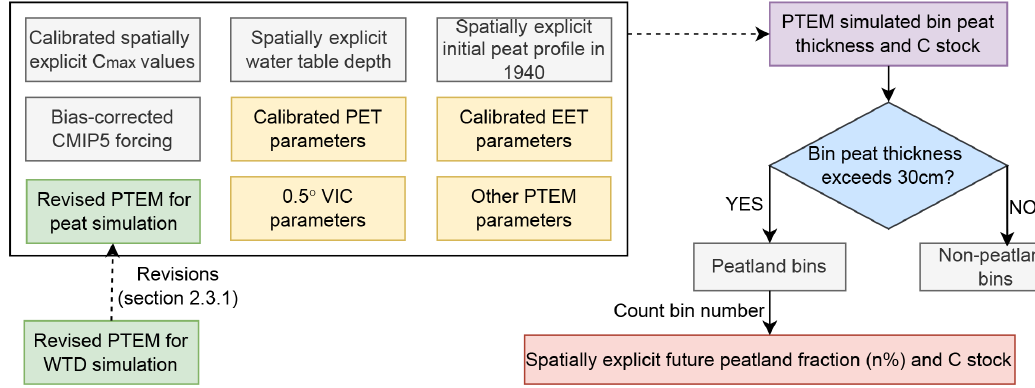
Figure 3. Flow chart for Sect. 2.3.2, “PTEM simulation”, in the Methods section.